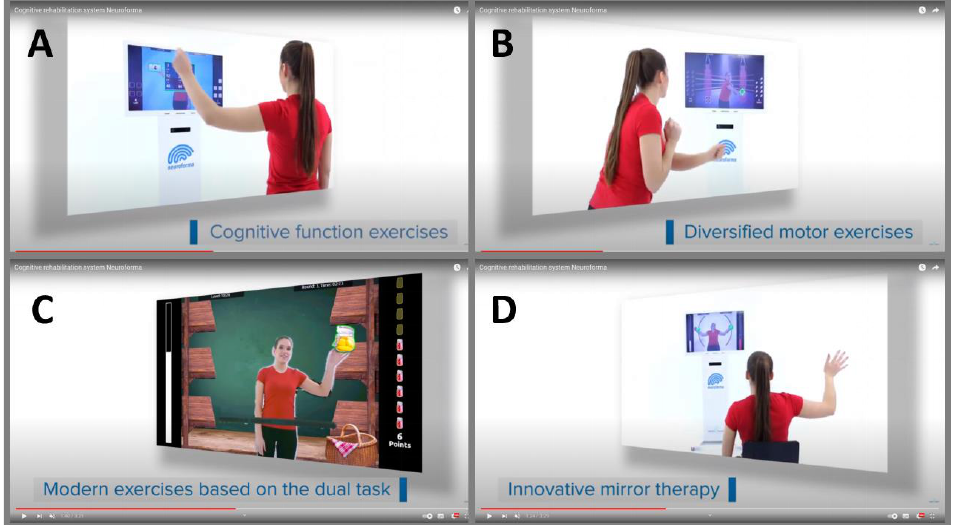
Figure 3. The presentation of examples of various exercises in the VR NEUROFORMA environment, such as ( A ) the arithmetic operations executive exercise, ( B ) the opposing boxing motor exercise, ( C ) the market products cognitive-motor exercise based on the dual task, ( D ) mirror paths exercise (materials from our lab repository, with the permission of Titanis Ltd.).